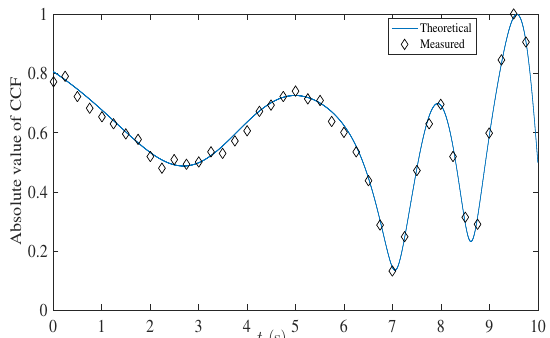
Figure 11. The absolute values of the theoretical and measured cross-correlation functions